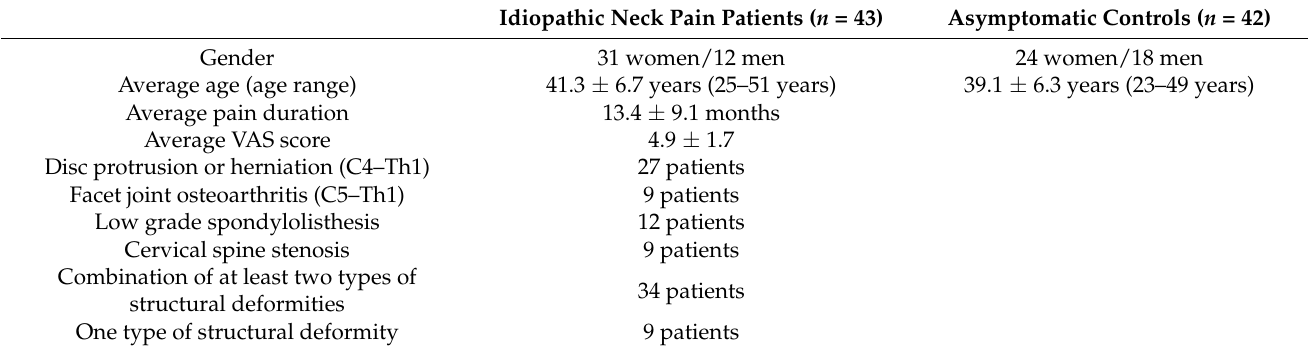
Table 1. Demographic